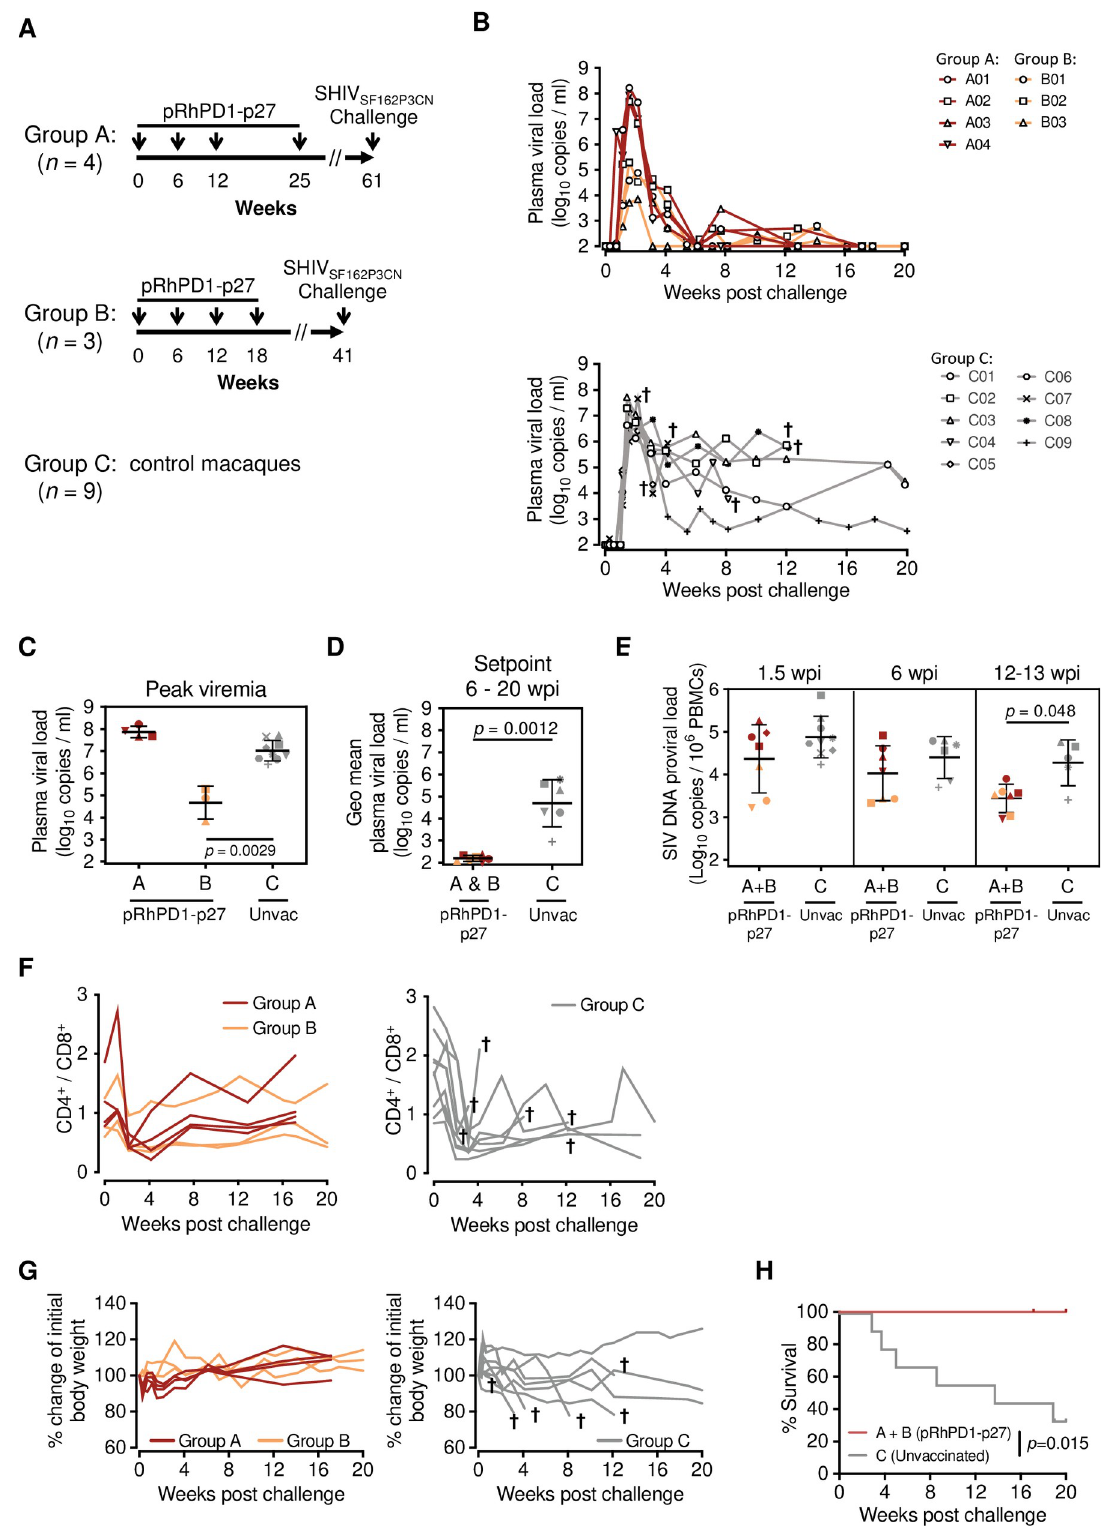
Fig 2. Viral suppression in rhesus macaques immunised with the PD1-based pRhPD1-p27 DNA vaccine after high dose pathogenic SHIV SF162P3CN challenge. (A) Schematic of DNA vaccination in Chinese-origin rhesus macaques. Two studies with different